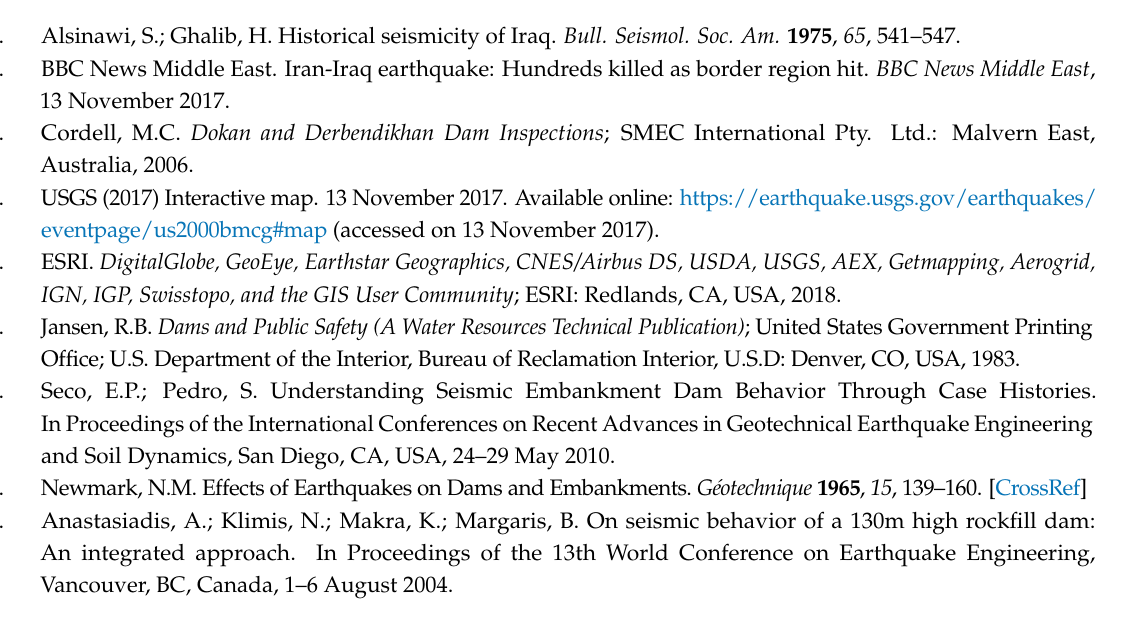
Figure S1. Co-seismic interferogram (7 November 2017–19 November 2017): (a) Interferogram, and (b) Coherence. Derbandkhan dam is indicated with white oval. Figure S2. The horizontal (indicated by arrows) and vertical (indicated by circles) displacements of the monitoring pillars on Derbandkhan dam measured by GPS and levelling. The source of the background image is from [5]. Note that (i) the horizontal displacements are referenced to ITRF08, and (ii) the pillars labelled with letter H were measured with GPS only. Figure S3. The corresponding error maps of the mean linear velocity maps in Figure 4a,b respectively. Note that the error maps show the RMS differences between InSAR derived displacements and a temporally linear deformation model. Table